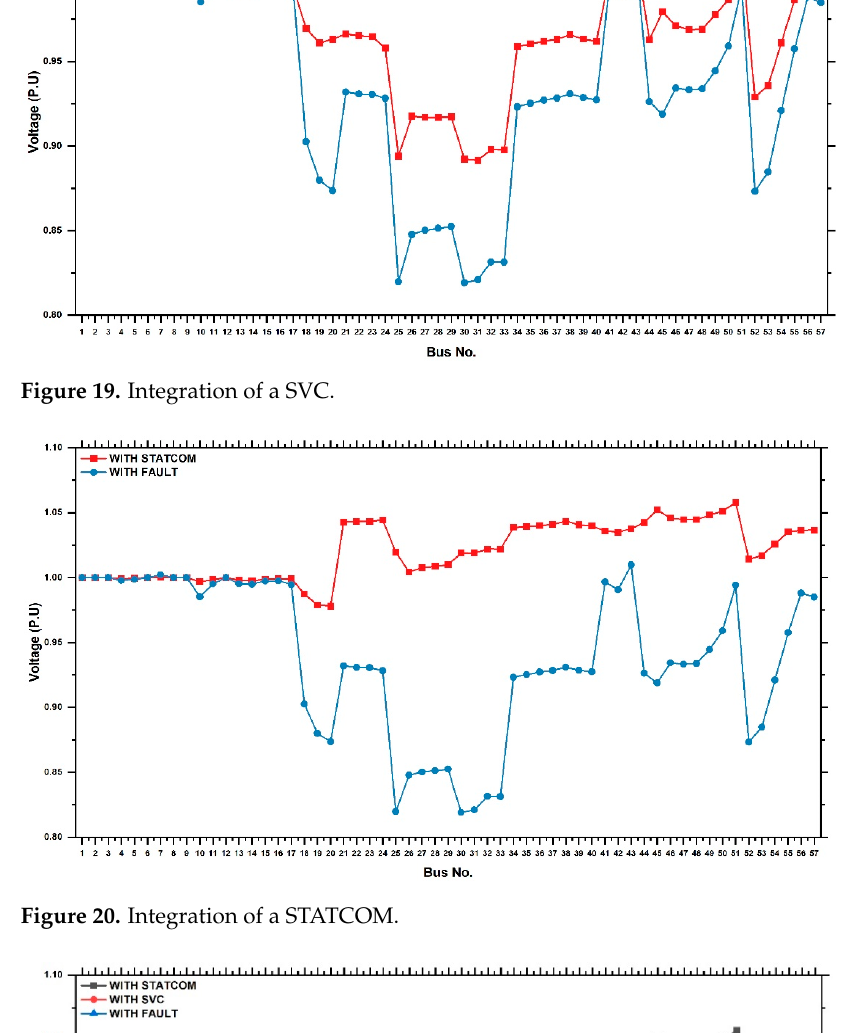
Figure 20. Integration of a STATCOM.